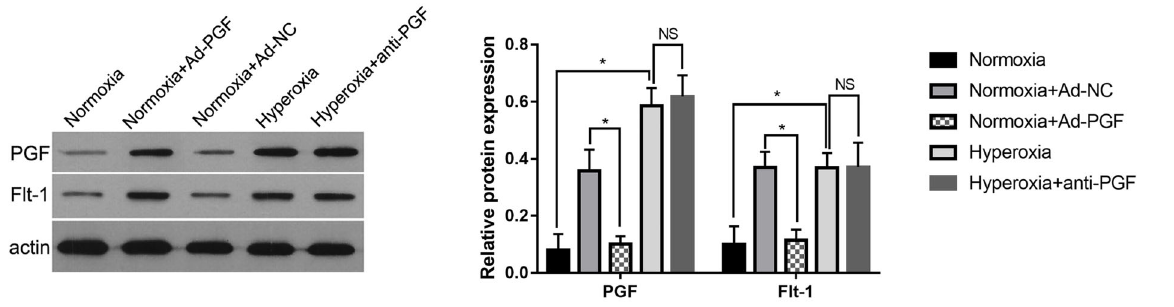
Figure 2. Placental growth factor (PGF) and Flt1 expression in the lung tissues of newborn rats of each group (n=10) detected by western blot analysis. Actin served as the internal loading control. Representative western blots (left) and statistical results of relative protein expression (right) are shown. Data are reported as means ± SD. *P o 0.05 (ANOVA). Ad-NC: adenovirus-negative control; Ad-PGF: adenovirus-placental growth factor; NS: not signi fi